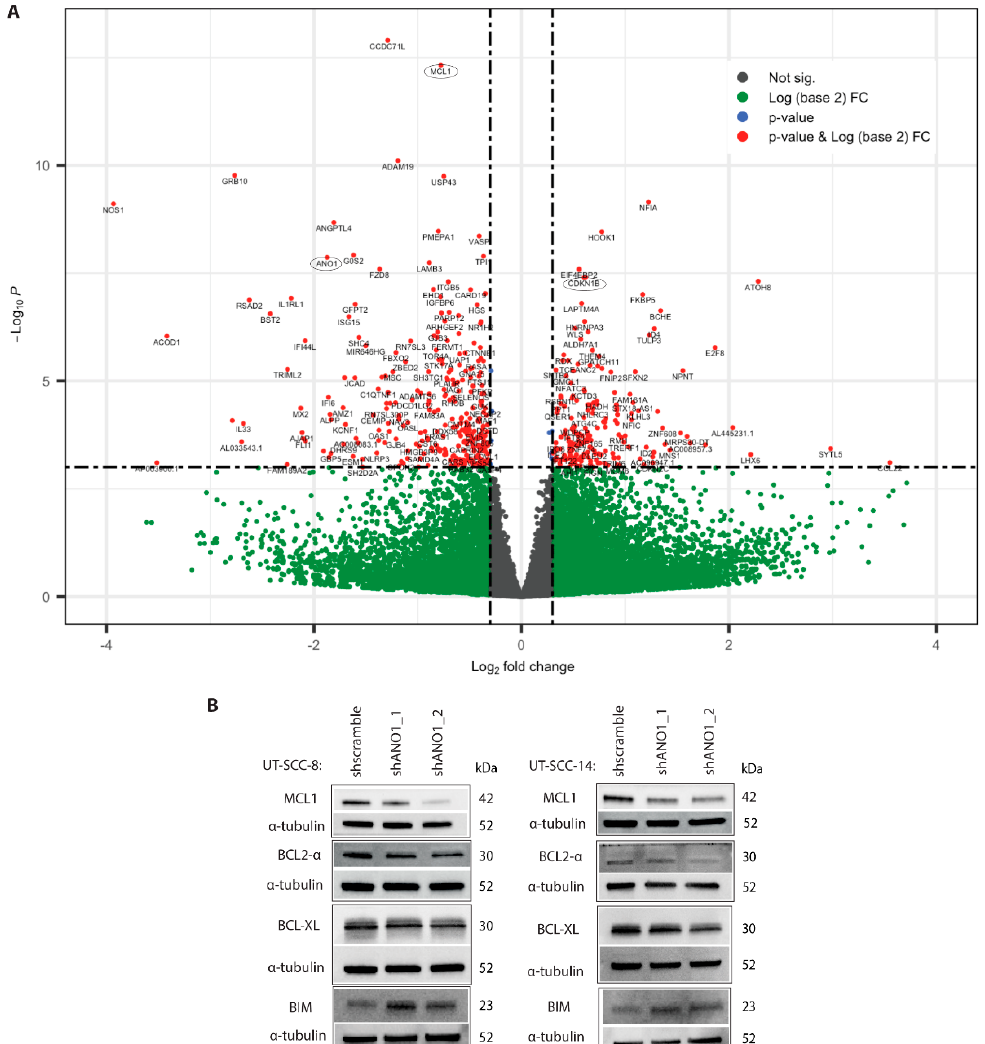
Figure 2. RNA sequencing revealed differential expression of genes involved in ANO1 signaling. ( A ) Volcano plot illustrating the differentially expressed genes. Each gene is represented by a dot. Red-colored genes pass the cutoffs of p adj , 10 × 10 − 4 and log2FC, 0.30 (above the horizontal dash line). ( B ) Western blots showing the differential protein expression between shScramble and shANO1 of key BCL2 family members, including pro-survival MCL1, BCL2, and BCL-XL, as well as pro-apoptotic BIM in UT-SCC-8 and UT-SCC-14 cell lines. Alpha-tubulin is the loading control.